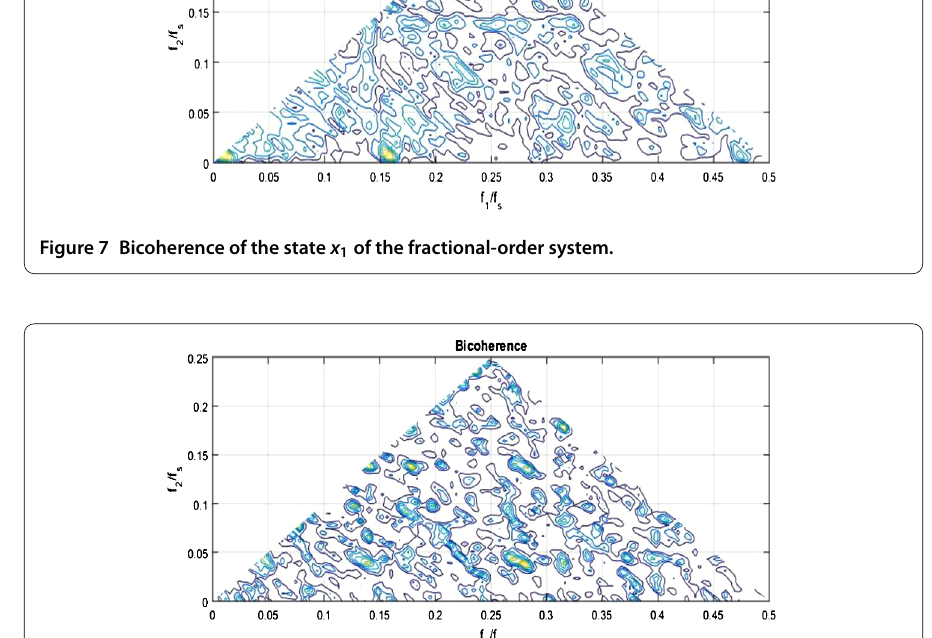
Figure 8 Bicoherence of the state x 2 of the fractional-order system.